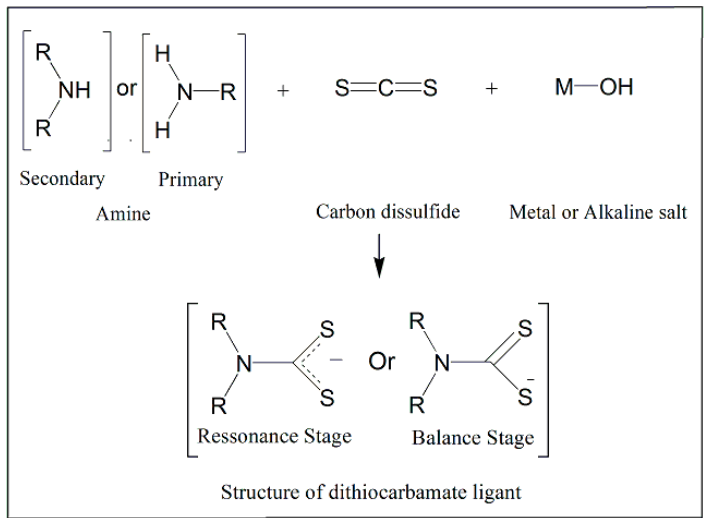
Figure 1. Schematic representation of the chemical synthesis of dithiocarbamates-based compounds.